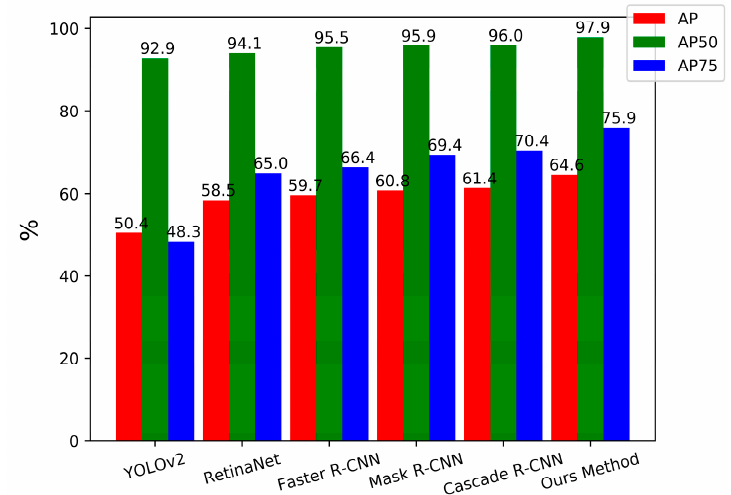
Figure 13. Comparison with the state-of-the-art single-model detectors on the SSDD data set. The red, the green, and blue bar chart represent AP, AP 50 , and AP 75 of the state-of-the-art single-model detectors, respectively.